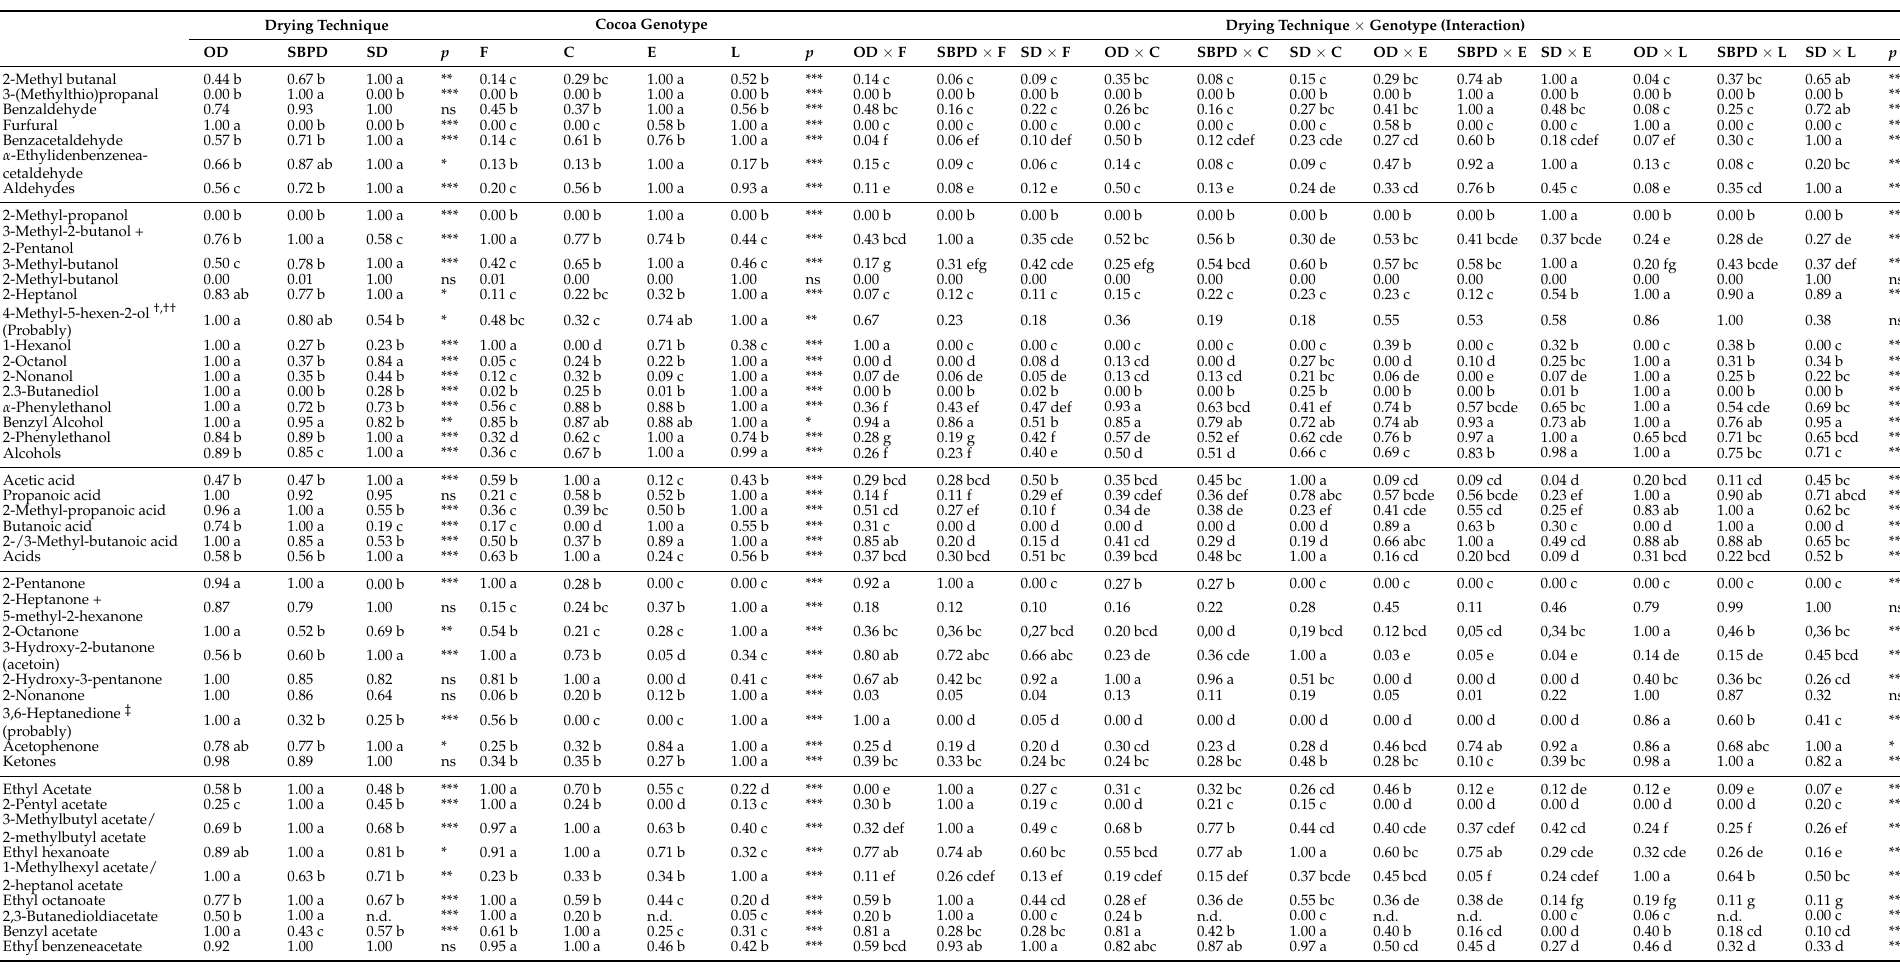
Table 1. Significance of two-way analysis of variance (ANOVA) for the volatile compounds of cocoa from bulk (Forastero (F) and CCN-51 (C)) and fine-flavor (ETT-103 (E) and LR14 (L)) genotypes and dried by three techniques, namely oven drying (OD), sun drying (SD), and sun drying using a black plastic on a concrete floor (SBPD). Data are expressed as the fold change relative to the maximum peak area of metabolites in each